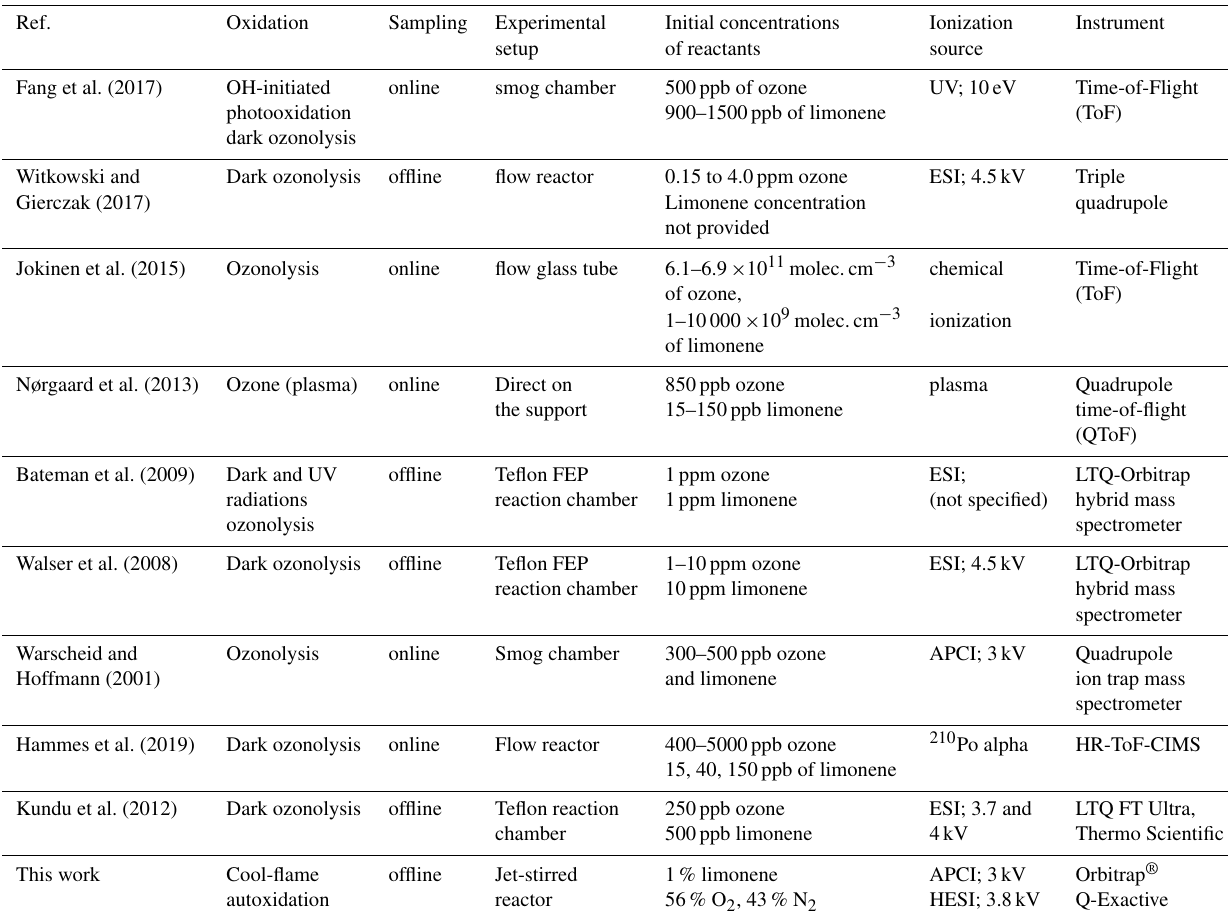
Table 1. Main experimental parameters for studies of limonene oxidation.